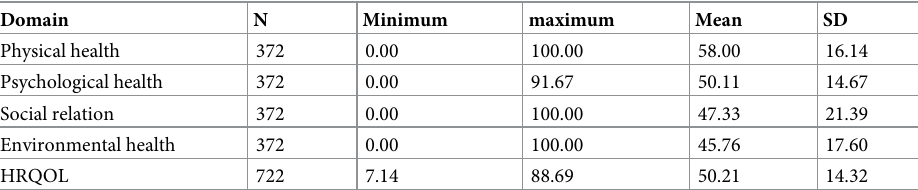
Table 2. HRQOL of substance youths in central Gondar zone, 2021.